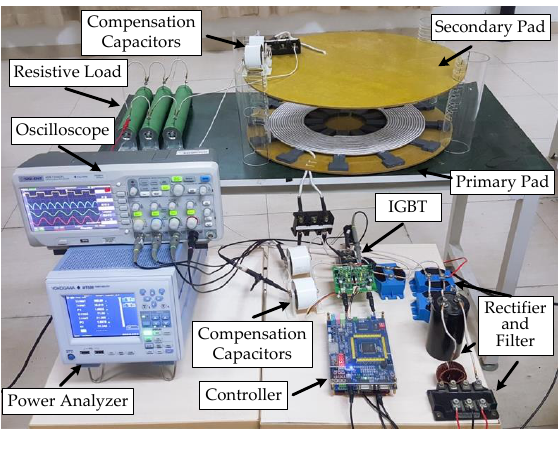
Figure 8. A 1.5 kW prototype of SHRC. Table 1. Parameters for SHRC and FRC 1.5 kW IPT systems.